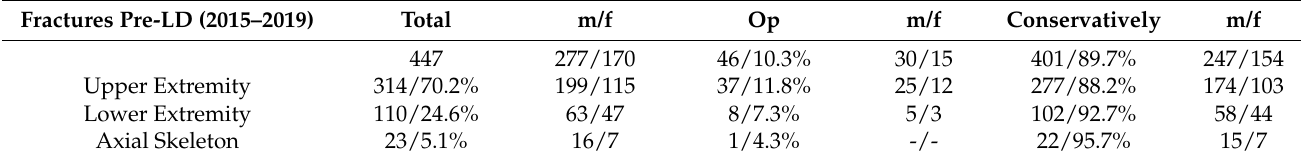
Table 4. Distribution of fractures according to region, sex and treatment modality in the pre-LD period.